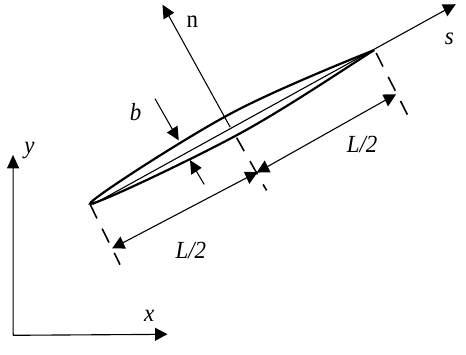
Figure 2. A single fracture